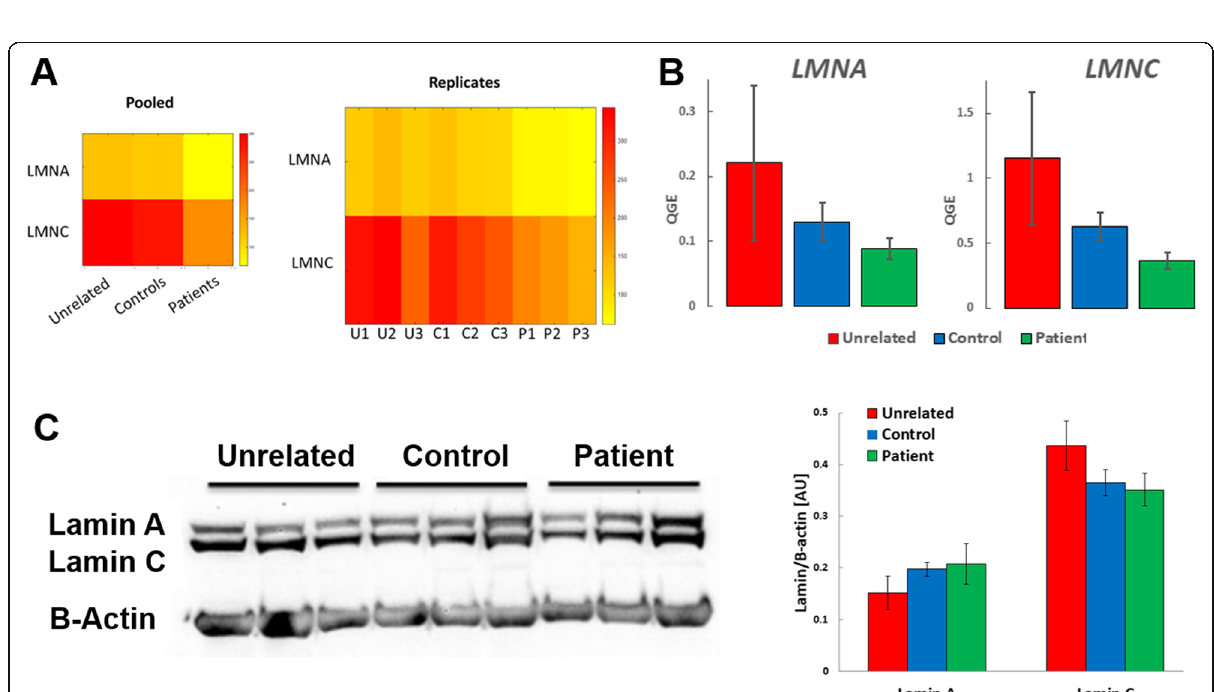
Fig. 1 Gene expression profiling of fibroblast samples by RNA-seq. Differential gene expression analysis was performed using Tophat and Cufflinks software and visualized using cummeRbund. Heatmaps of gene expression profiles are clustered by rows (genes). Heatmaps are shown as pooled samples (left panel) and replicates (right panel)